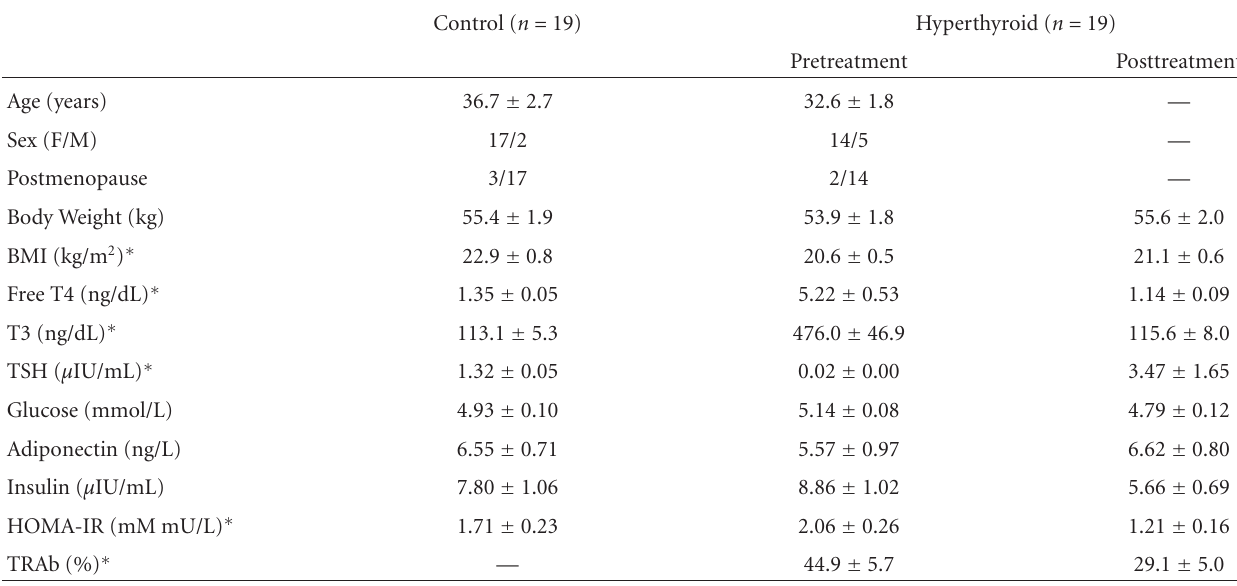
Table 1: Characteristics of control subjects and hyperthyroid subjects before and after